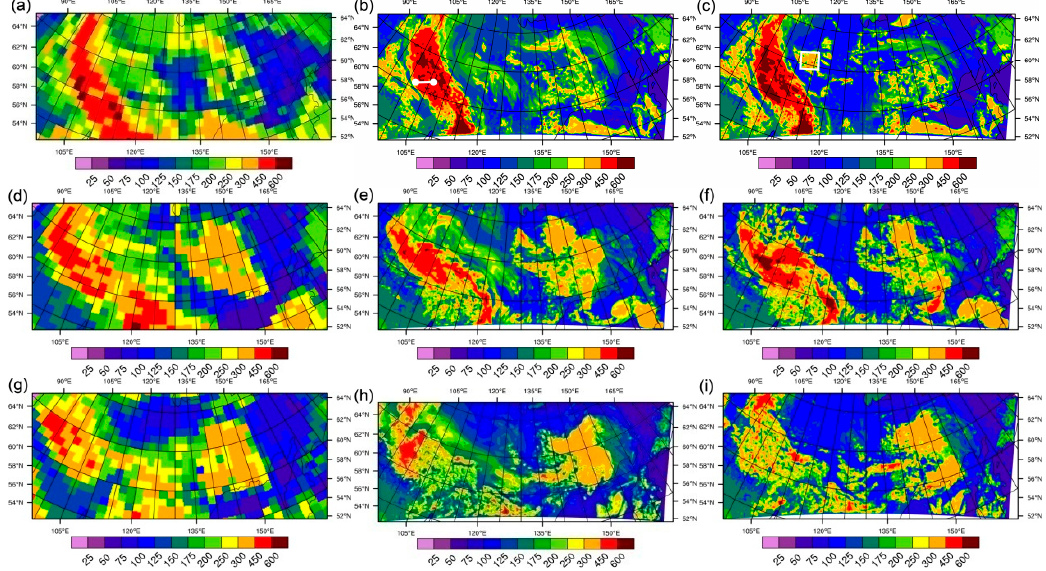
Figure 8. ( a ) SRB SW TOA ↑ , ( b ) SW TOA ↑ modeled by SMOKE and ( c ) CLEAN during FP2 at 0600 UTC on 19 August 2002. ( d ) SRB SW TOA ↑ , ( e ) SW TOA ↑ modeled by SMOKE and ( f ) CLEAN during FP2 at 0600 UTC on 20 August 2002. ( g ) SRB SW TOA ↑ , ( h ) SW TOA ↑ modeled by SMOKE and ( i ) CLEAN during FP2 at 0600 UTC on 21 August 2002. The white line on ( b ) shows the cross-section as discussed in Figure 10. The white square on ( c ) indicates the region used for analysis in Figure 11.